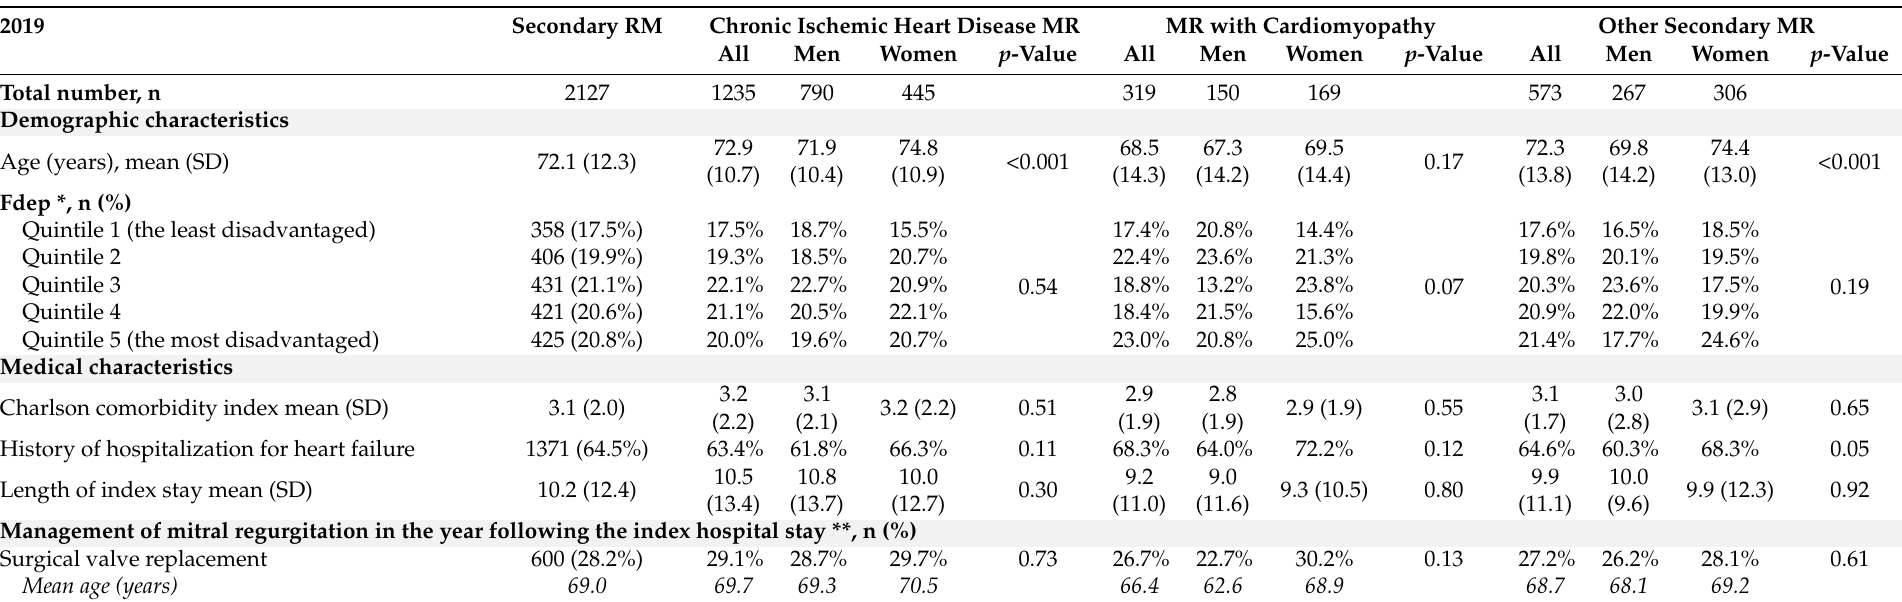
Table 2. Characteristics of patients hospitalized for secondary mitral regurgitation according to etiology and sex, France,